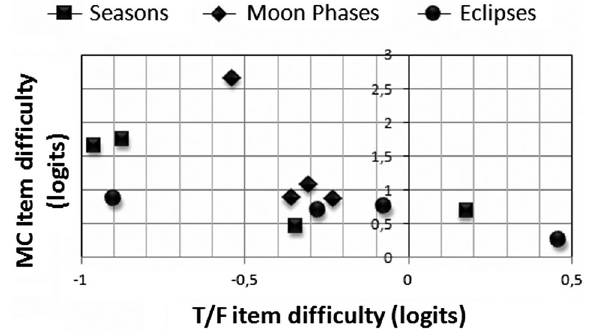
FIG. 3. Relationship between the mean difficulty of the first and second tier of the questionnaire.